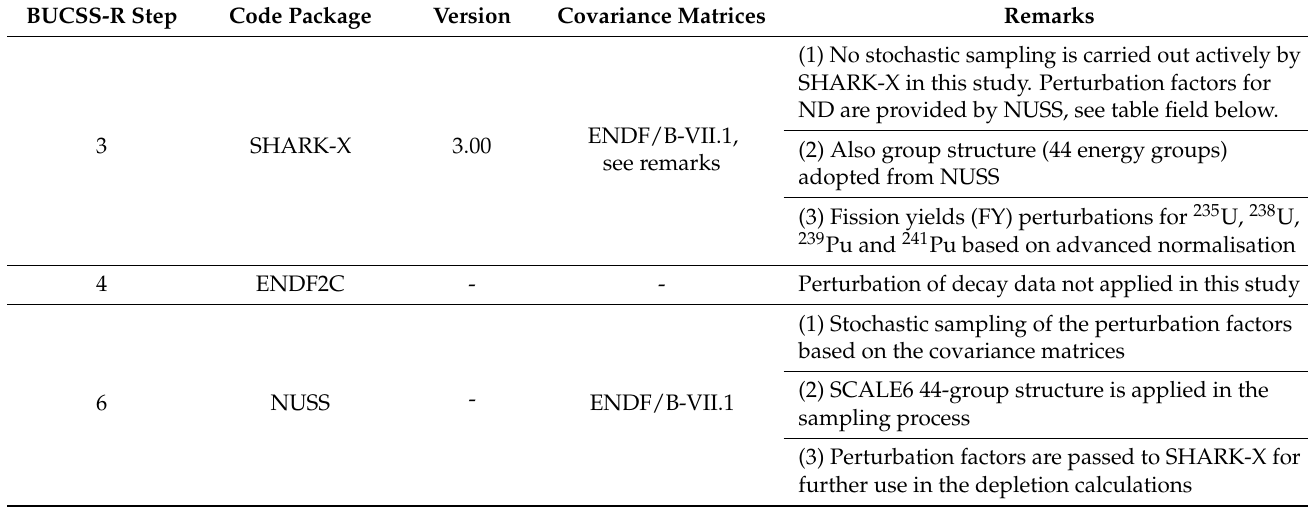
Table 3. Overview about materials and data used in nuclear data uncertainty quantification (ND-UQ) modules of this